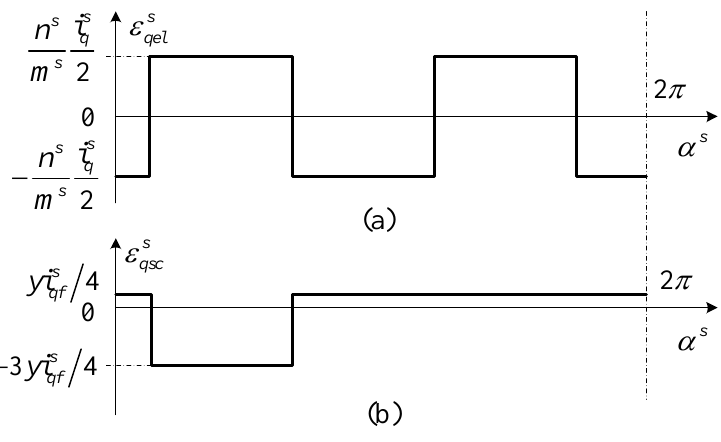
Figure 6. Mmf components generated by elementary damaged coil created by: (a) two healthy elementary sections; (b) y short-circuited